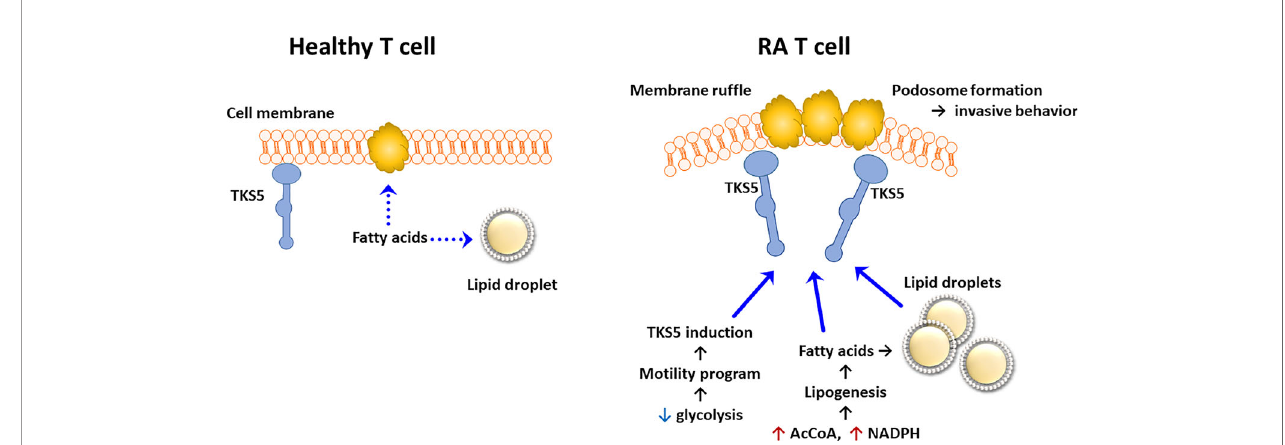
FIGURE 4 | Pathogenic Lipogenesis in RA T cells. Metabolic rewiring in RA T cells, including the shunting of glucose to the pentose phosphate pathway, the export of mitochondrial citrate and the suppression of mitochondrial lipid oxidation, all favor lipogenesis over lipolysis. As a result, RA T cells deposit lipid droplets in the cytoplasm and are rich in biosynthetic precursors for membrane lipids. Lowered glycolytic activity upregulates a module of motility genes, including the scaffolding protein TKS5. As part of their pro-in fl ammatory phenotype, lipogenesis-biased TKS5 hi RA T cells spontaneously form actin- and cortactin-rich membrane ruf fl es, equipping them tissue invasion and mobility in extracellular matrix. AcCoA, acetyl-CoA.